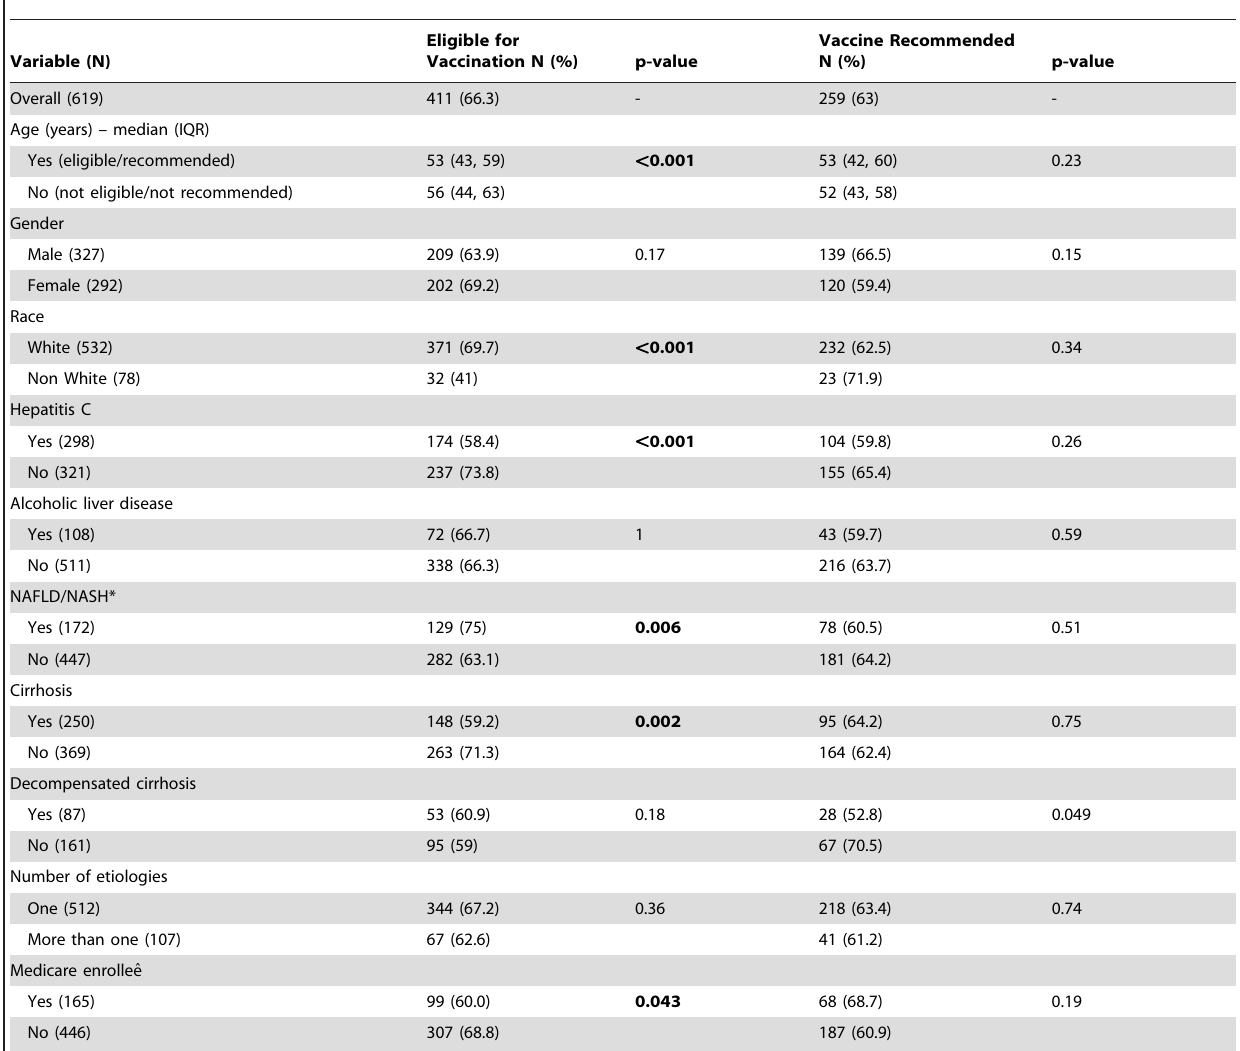
Table 3. Eligibility for Hepatitis A vaccination among 619 new chronic liver disease patients and the proportion where it was recommended at the liver